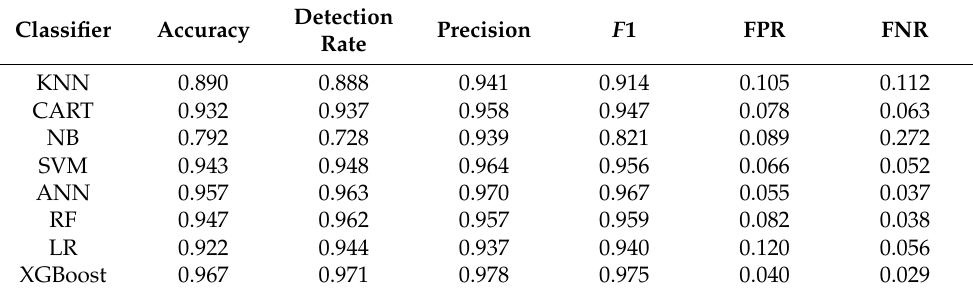
Table 3. Accuracy ( ACC ), Detection rate ( DR ), Precision ( P ), F -measure ( F 1), False positive rate (FPR), and False negative rate (FNR) for the proposed models with k = 1.0.